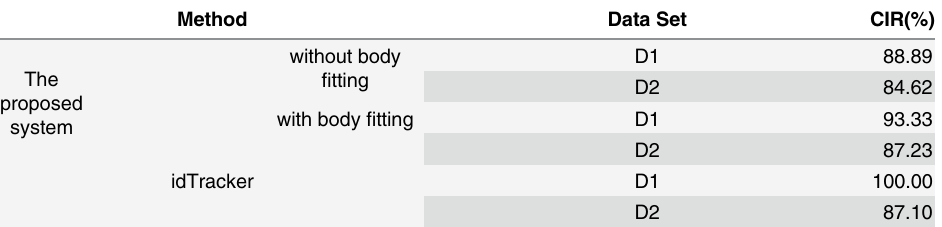
Table 7. CIR of the proposed system and idTracker.